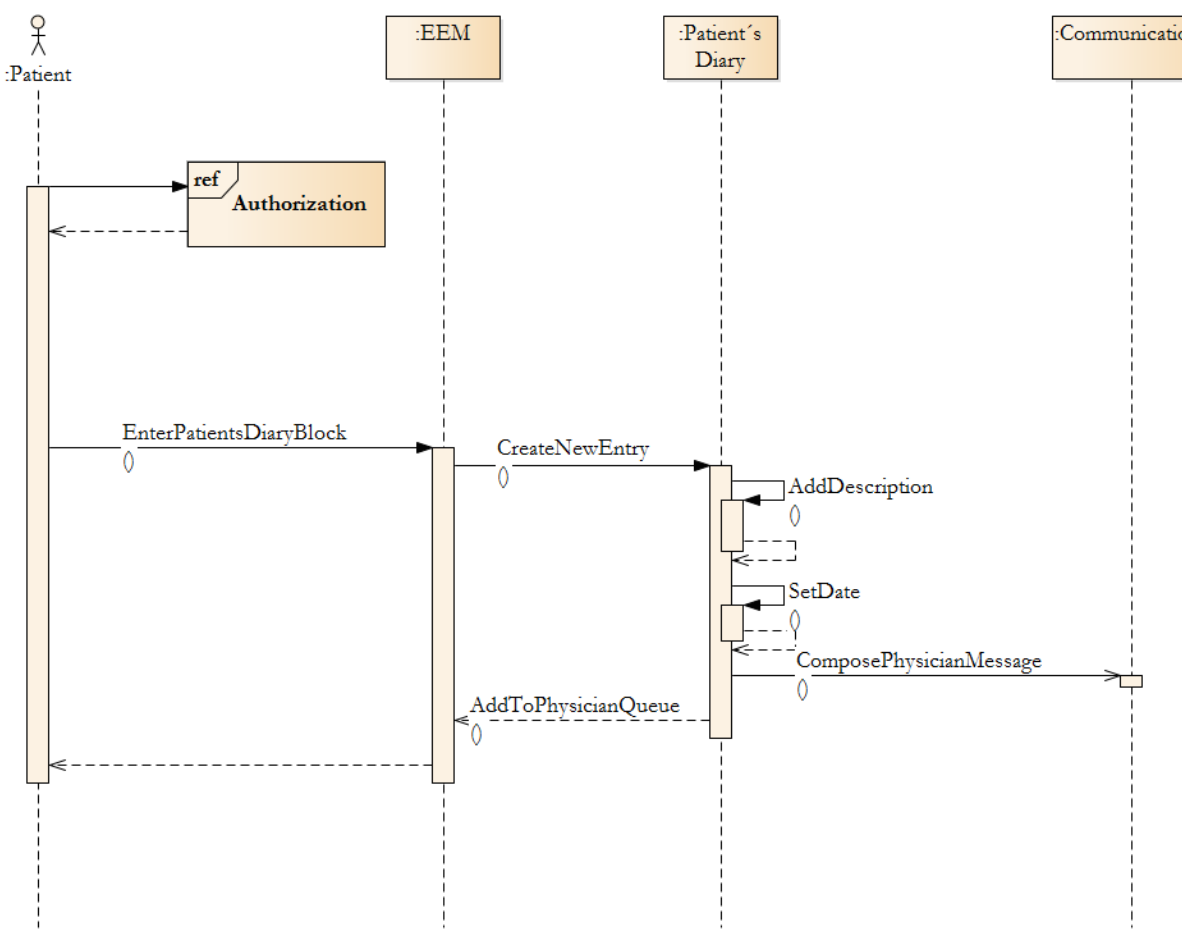
Figure 8. Patient diary entry submission process.